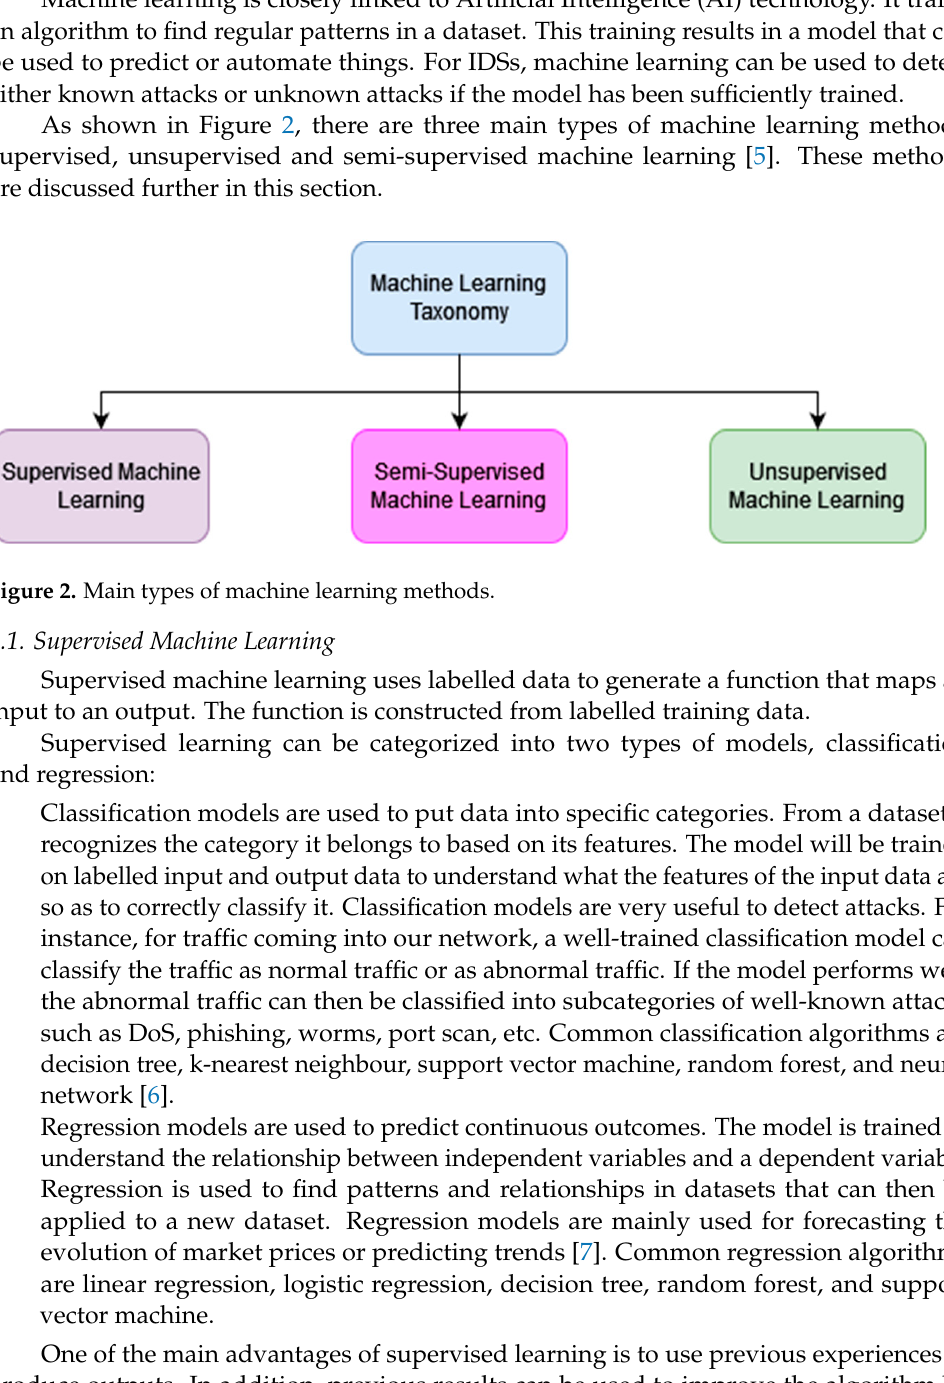
5 of 28 Figure 1. ROC Curves for different IDSs.